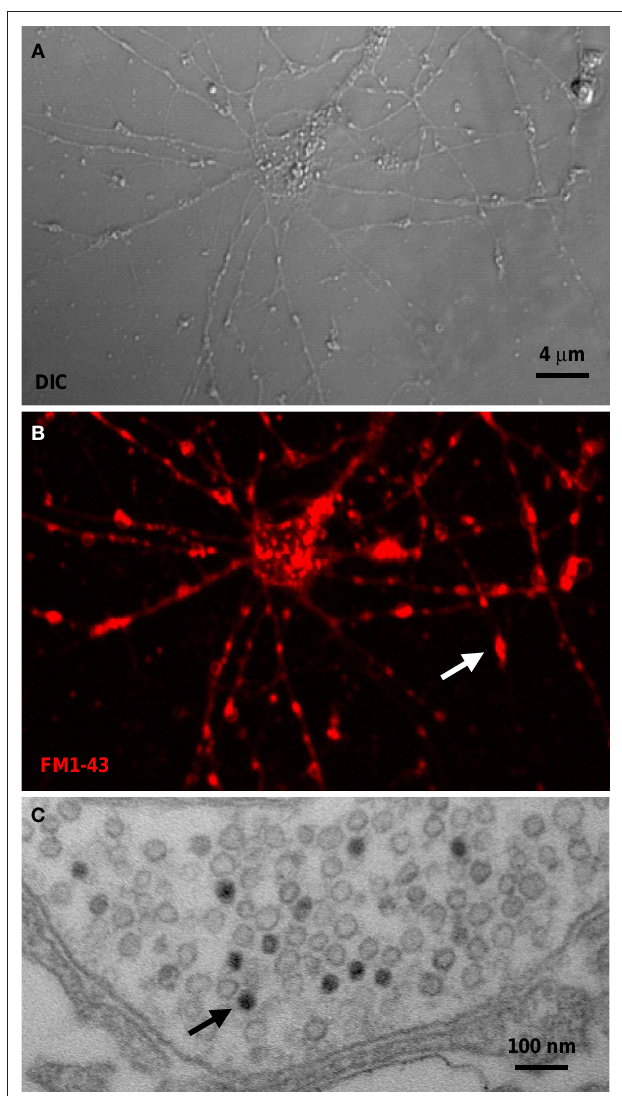
FIGURE 3 | Synaptic vesicle cycle imaging. (A) Nomarski (DIC) image of Drosophila primary brain neuron culture at 8 days in vitro . (B) The lipophilic dye FM1-43 loaded into vesicles by depolarization. Arrow points to a single synaptic bouton. (C) The fl uorescent FM1-43 signal can be photoconverted to an electron-dense signal in the presence of diaminobenzene (DAB) with high intensity 490 nm light. Arrow points to a single labeled synaptic